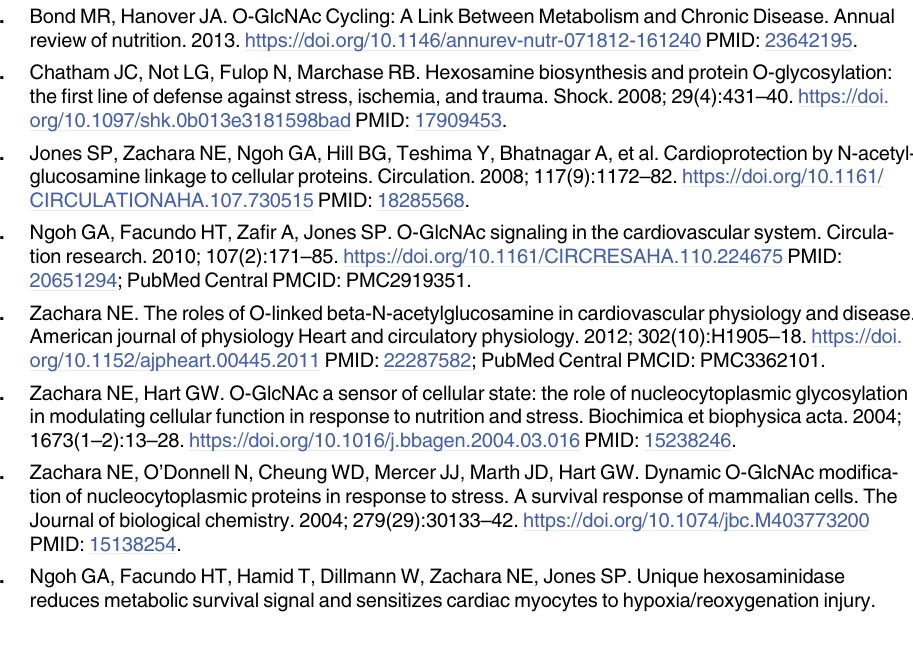
S6 Table. Patient demographics. Patient demographics of de-identified human samples. A chi-squared test was used to determined significance between NF and HF